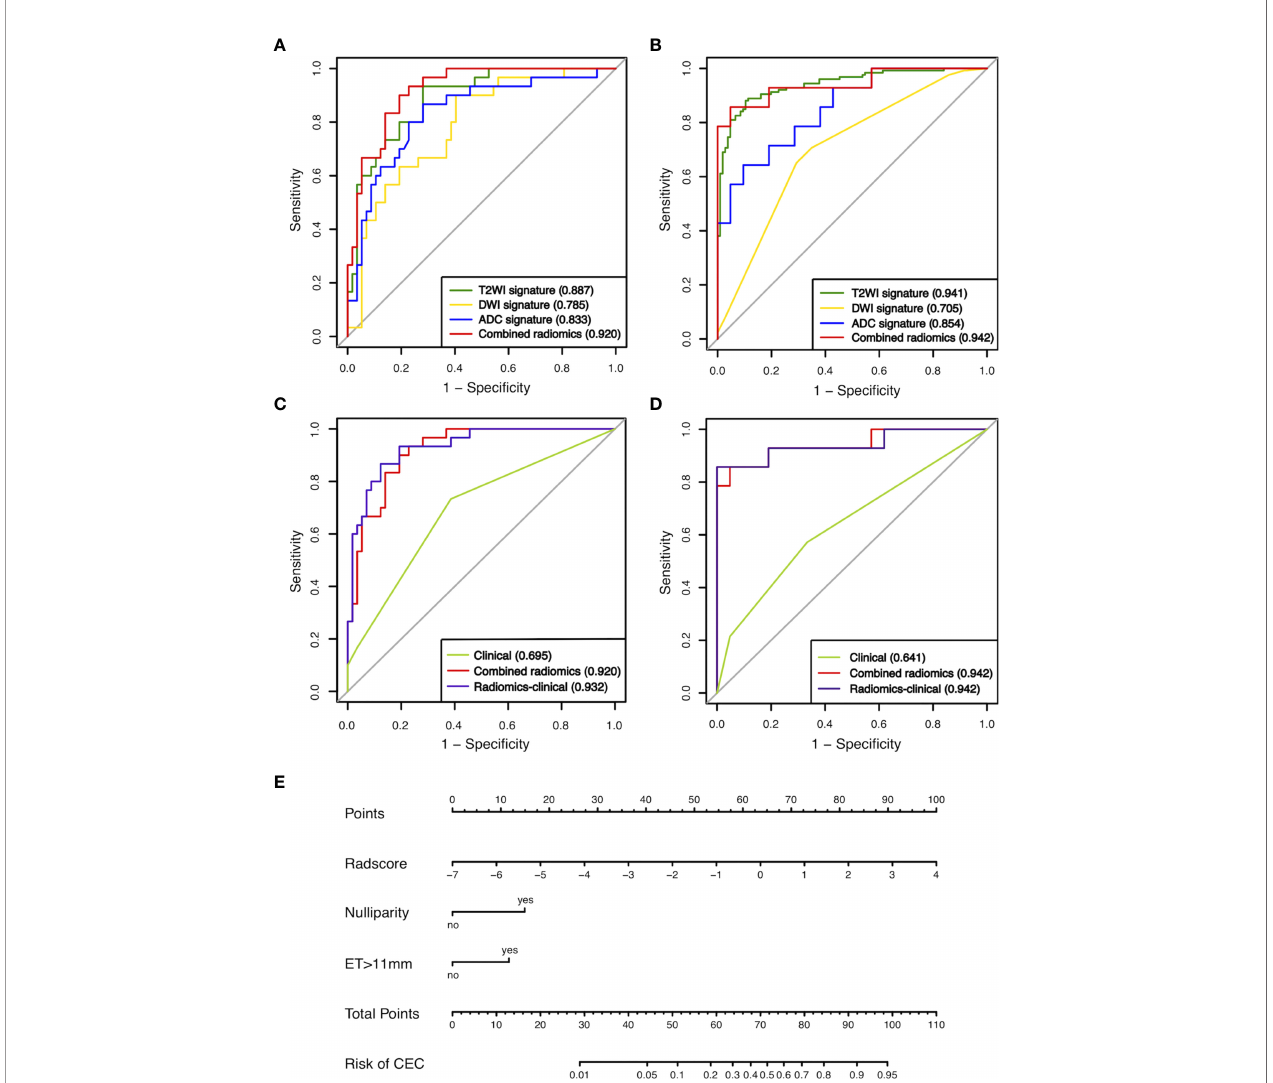
FIGURE 3 | ROCs of the four radiomics signatures in the training (A) and validation (B) sets. ROCs of the clinical model, radiomics signature, and radiomics-clinical model in the training (C) and validation sets (D) . (E) Preoperative nomogram of the radiomics-clinical model. ET, endometrial